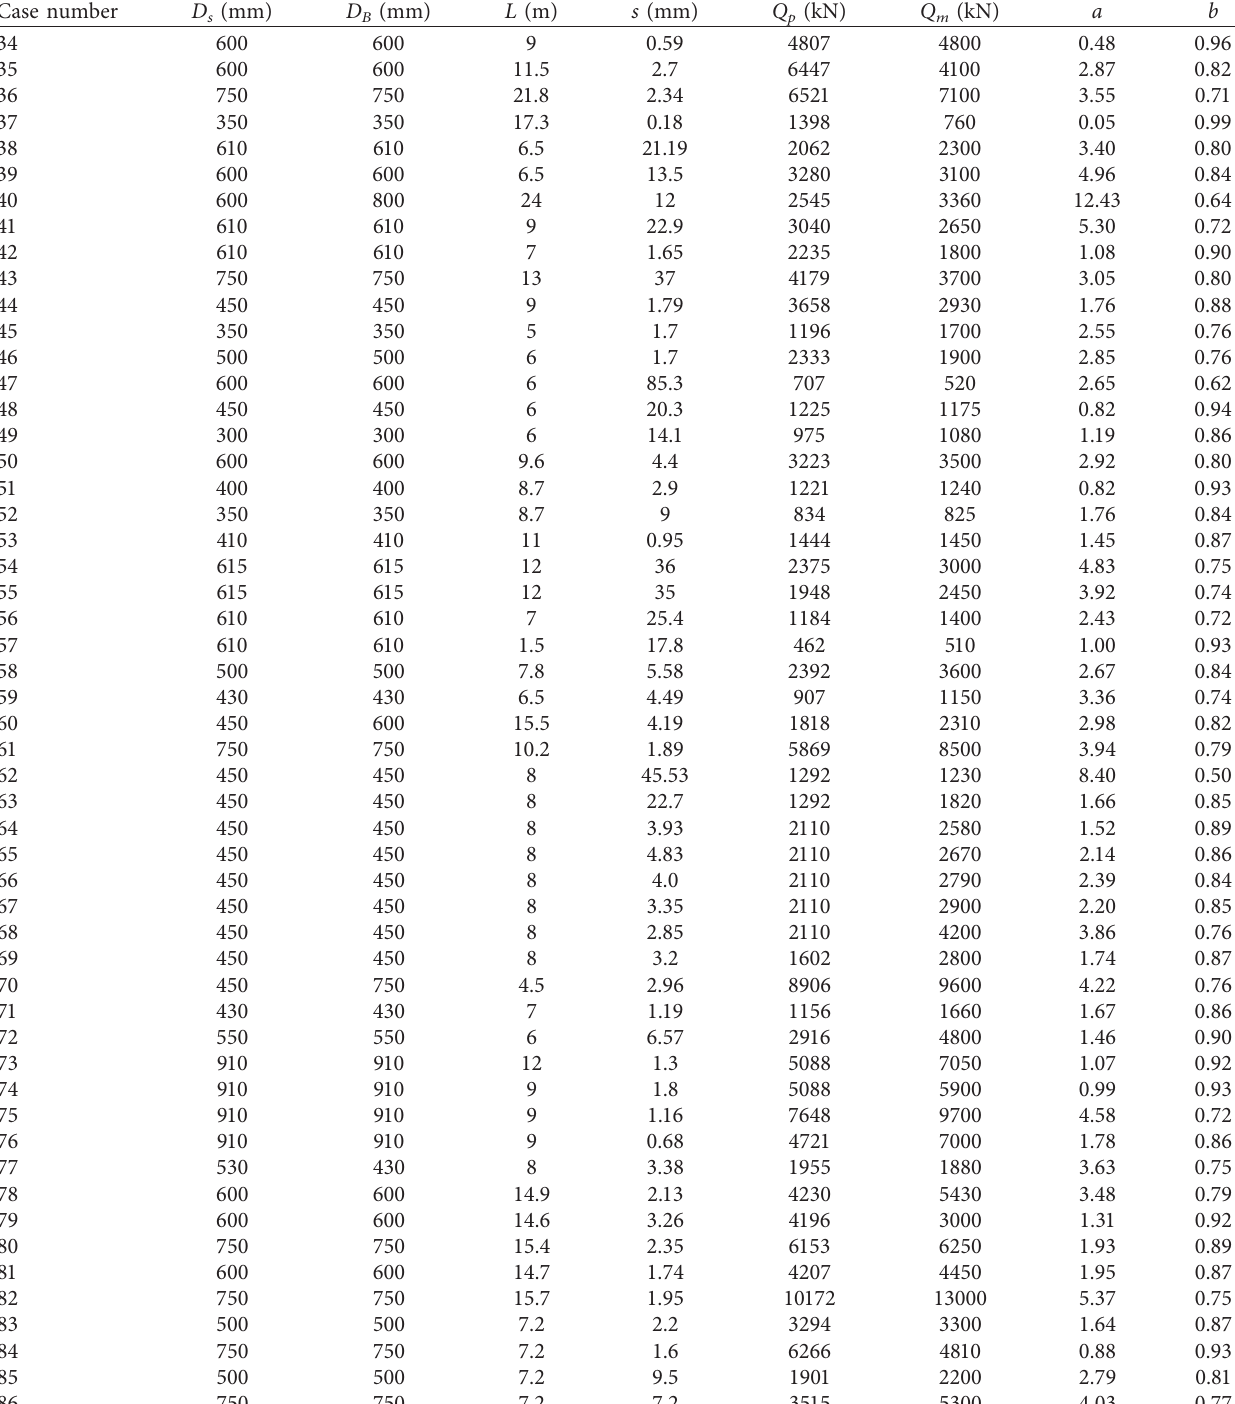
Table 2: Load testing data of pile capacity in cohesive